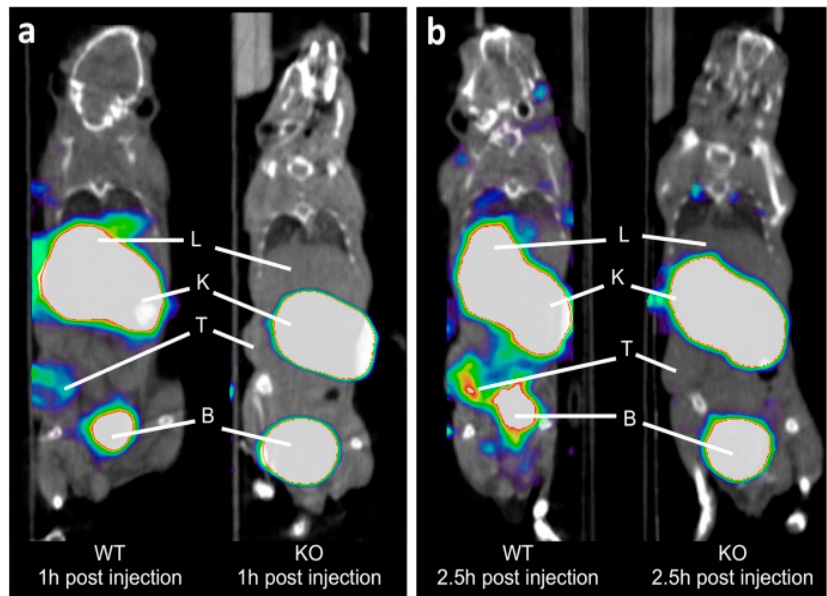
Figure 1. Coronal PET/CT images of [ 68 Ga]Ga-NOTA-anti-MMR-sdAb in 3LL-R tumor-bearing wild-type (WT) and CD206-deficient (KO) mice. Images collected at: ( a ) 1 h post injection and ( b ) 2.5 h post injection. PET signals in color scale overlaid on CT image in gray scale. T, K, L, and B are tumor, kidney, liver, and bladder, respectively. From Ref [45] used with permission.